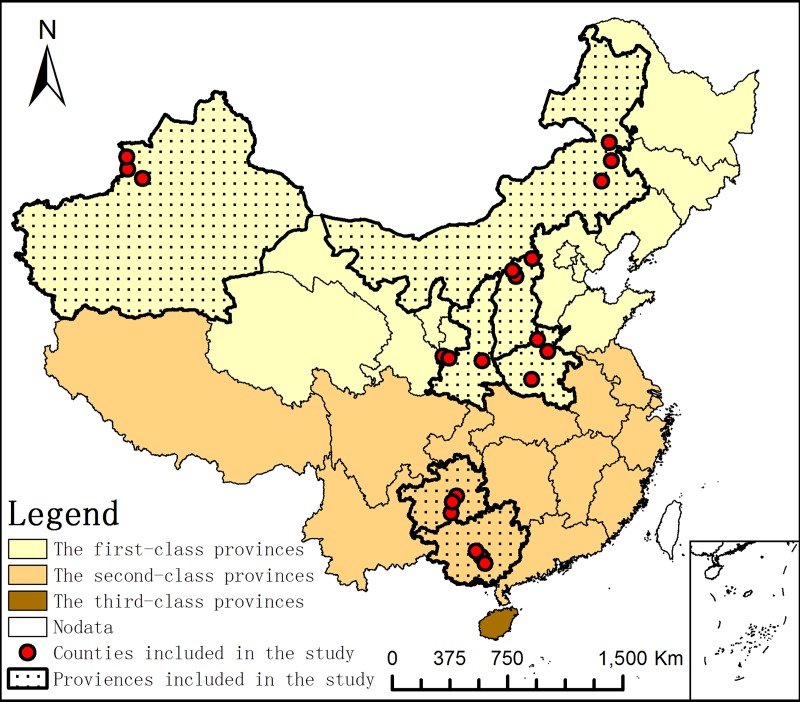
Map of the study area.Vector map file came from Resources and Environment Science Data Center, Chinese Academy of Sciences and was performed with ArcGIS10.4 software (ESRI INC., Redlands, CA, USA).